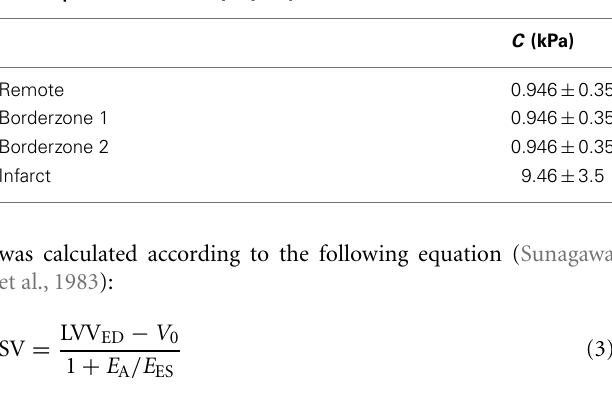
Table 2 | Passive material property ( C ) values used for all cases.